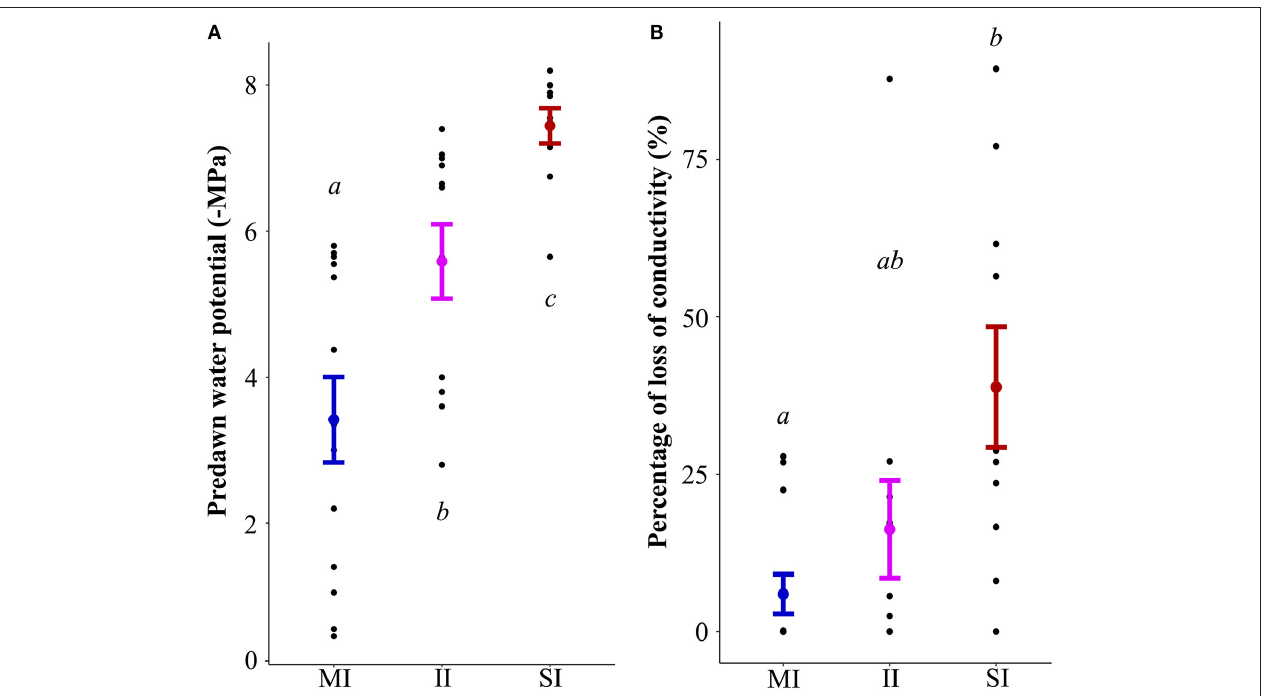
FIGURE 2 | Effect of the degree of impact (MI minimal impact, II intermediate impact and SI severe impact) on predawn water potential (-MPa) (A) and percentage loss of conductivity (B) . Mean ± standard error. Letters indicate significant differences from the ANOVA ( p < 0.05) between the sites.